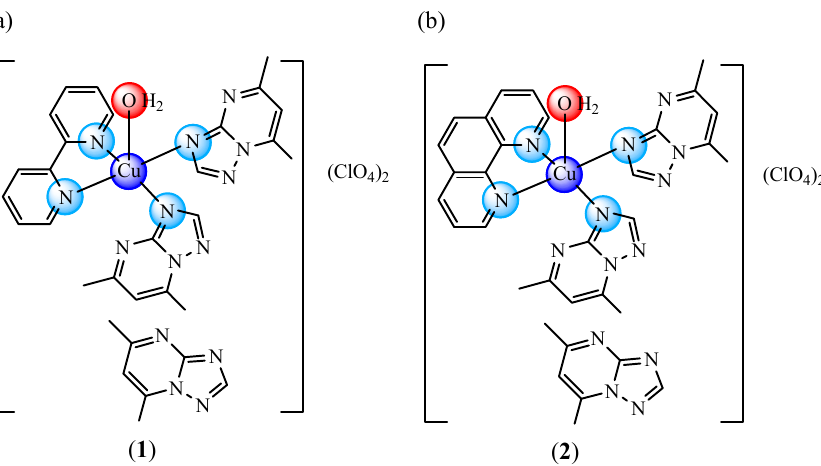
Figure 1. The molecular structure of complexes [Cu(bipy)(dmtp) 2 (OH 2 )](ClO 4 ) 2 ·dmtp ( 1 ) ( a ) and [Cu(phen)(dmtp) 2 (OH 2 )](ClO 4 ) 2 ·dmtp ( 2 ) ( b ).